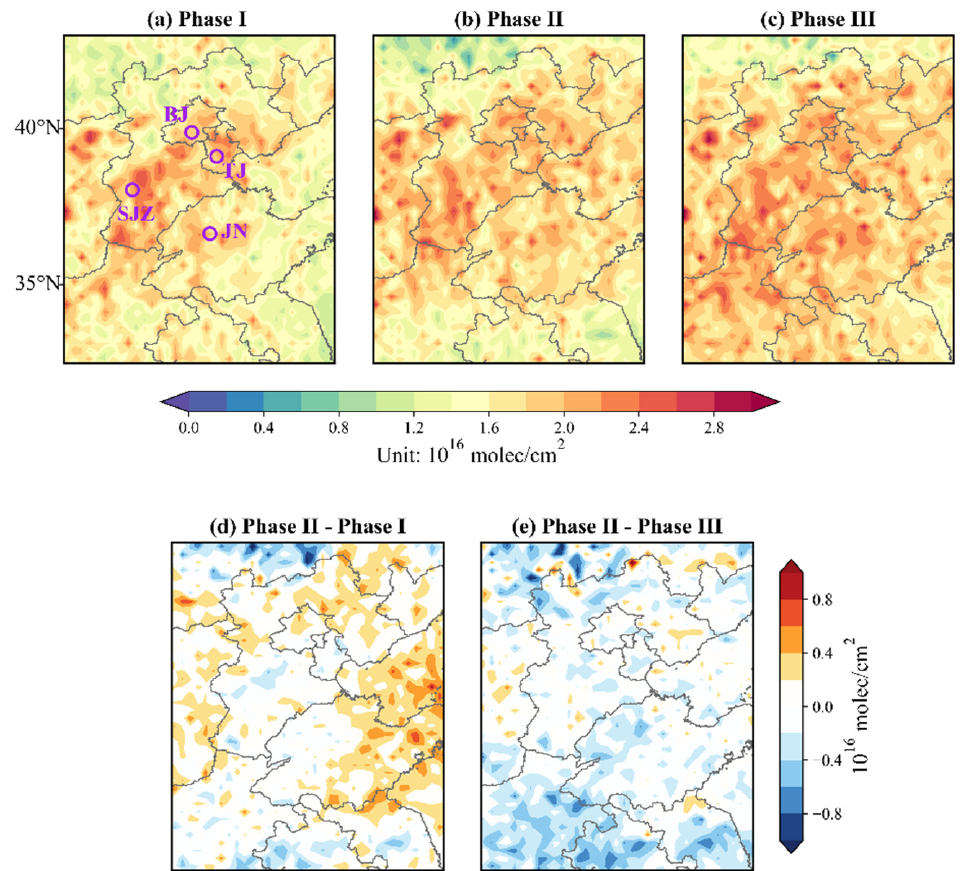
Figure 11. ( a – c ) SO 2 VCDs from corrected TROPOMI in North China for Phase I (before COVID-19), Phase II (COVID-19 lockdown) and Phase III (after COVID-19 lockdown) periods. ( d ) The differences between Phase II and Phase I. ( e ) The differences between Phase II and Phase III. Circle markers indicate major capital cities over this region. From top to bottom are Beijing (BJ), Tianjin (TJ), Shijiazhuang (SJZ) and Jinan (JN) (units: 10 16 molec cm − 2 ). In general, high NO 2 accumulation was similar to SO 2 , which may appear over the sim- ilar hot spots in North China. For quantitative comparison, four major capital cities over this target region have been given and discussed in Figure 12. The tropospheric NO 2 columns in all spots experienced a dramatic drop during Phase II and then recovered progressively. Specifically, the NO 2 VCDs decreased by 0.28, 0.22, 0.39 and 0.38 × 10 16 molec cm − 2 in Beijing (BJ), TJ, Shijiazhuang (SJZ) and JN areas, respectively, between Phase I and Phase II, reflecting overall lower emissions during this period. Then, significant growth appeared in phase III, indicating that a recovery to previous years after the epidemic remission is expected. As for SO 2 , the columns in the lockdown period (Phase II) have changed little versus during the same period of Phase I. Subsequently, in Phase III, SO 2 levels in the four regions increased slightly, with the highest increase in JN by about